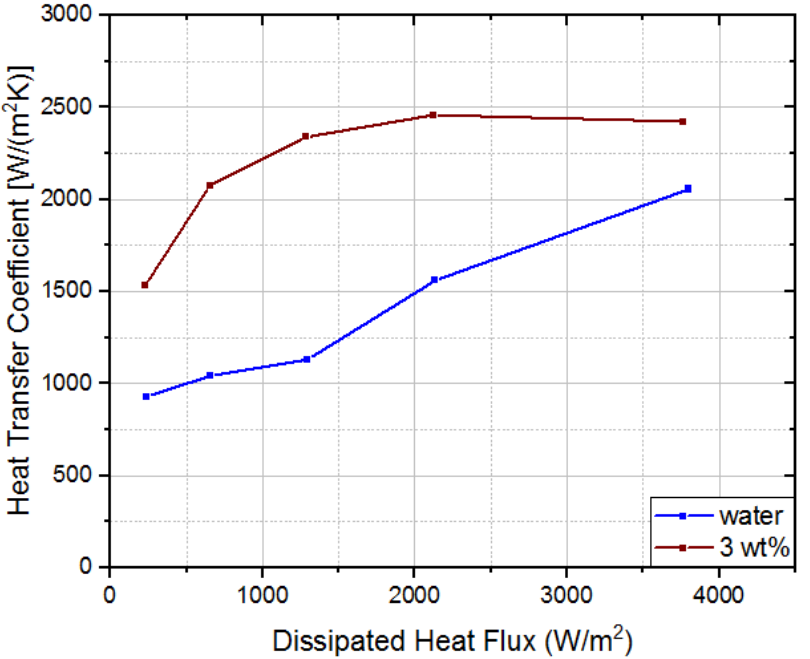
Figure 11. Dissipated heat flux versus heat transfer coefficient. Septuple superhydrophobic region with 1.5 mm diameter spots.